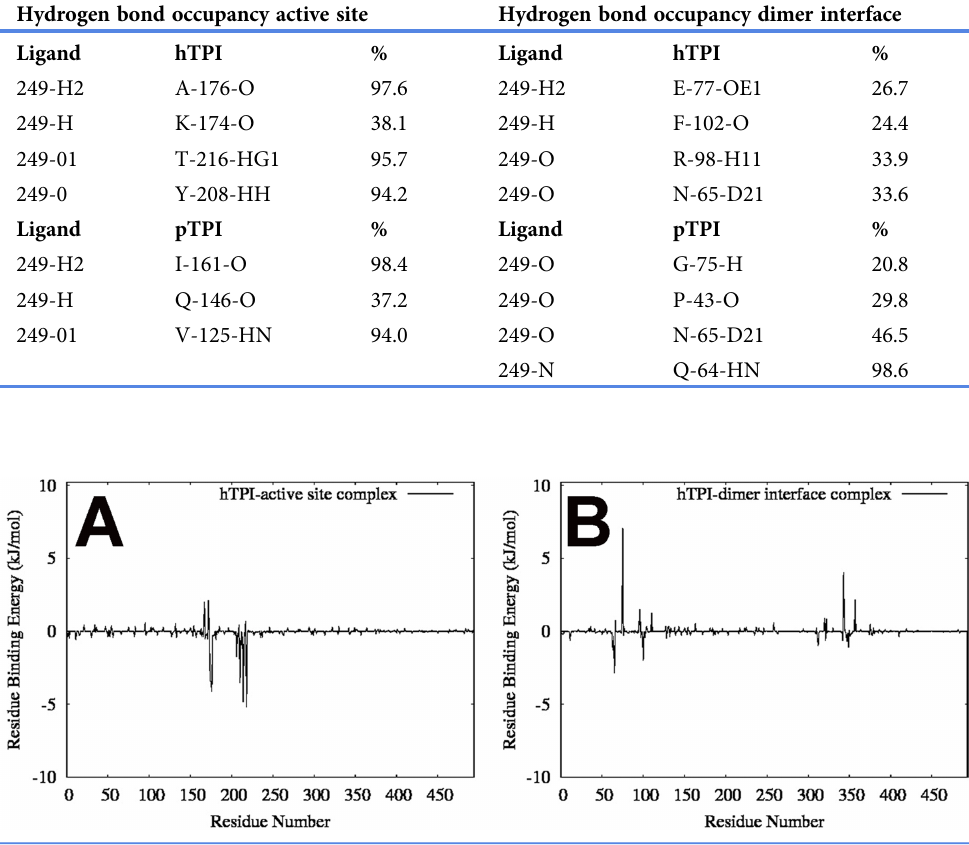
Table 3 Hydrogen bond occupancy for each residue in their respective complexes.